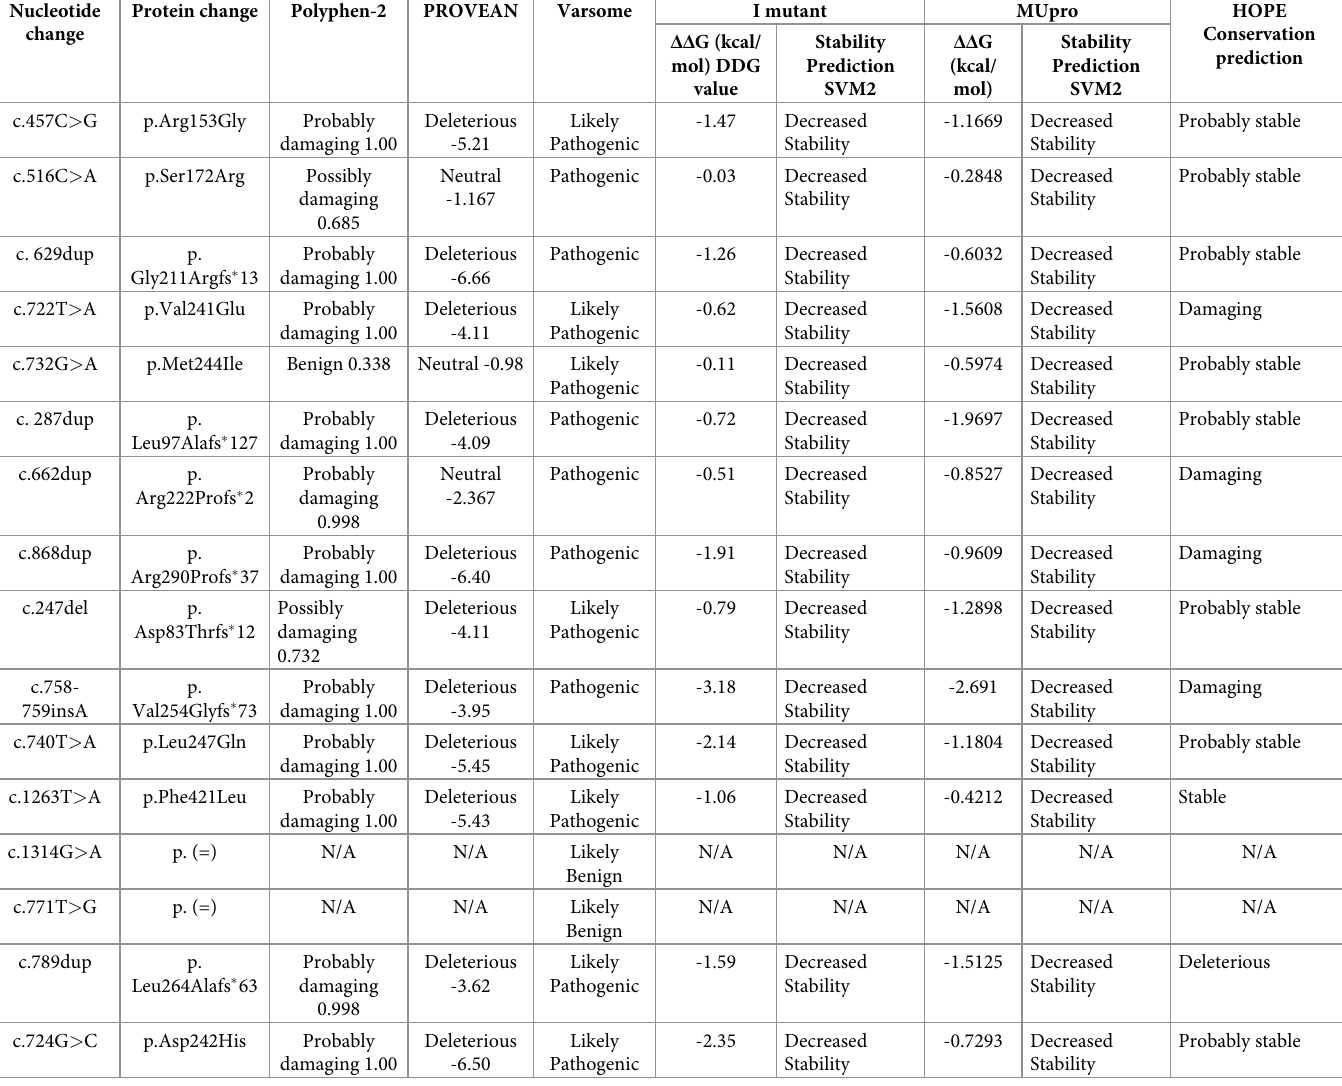
Table 3. In-silico analysis data of disease-causing variants identified in this